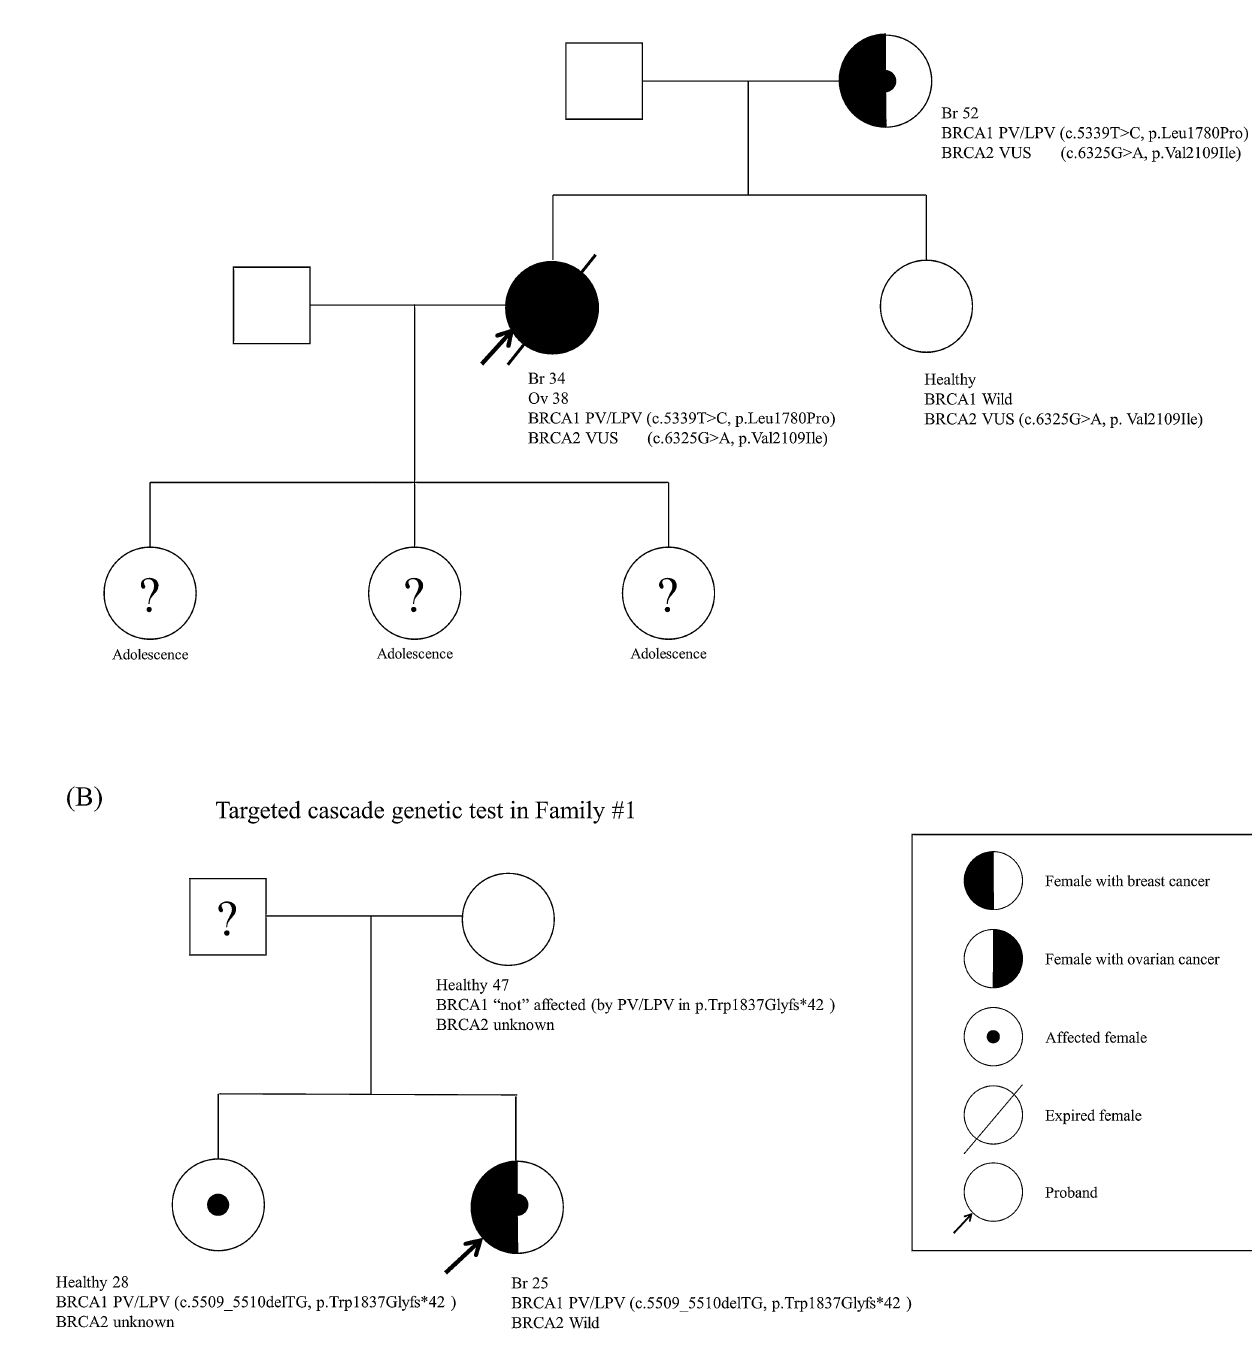
Figure 1. Schematic pedigree of families who underwent cascade genetic tests for BRCA1/2 genes. ( A ) Pedigree of family #2 who underwent conventional cascade genetic testing for BRCA1/2 genes. ( B ) Pedigree of family #1 who underwent targeted cascade genetic test for BRCA1/2